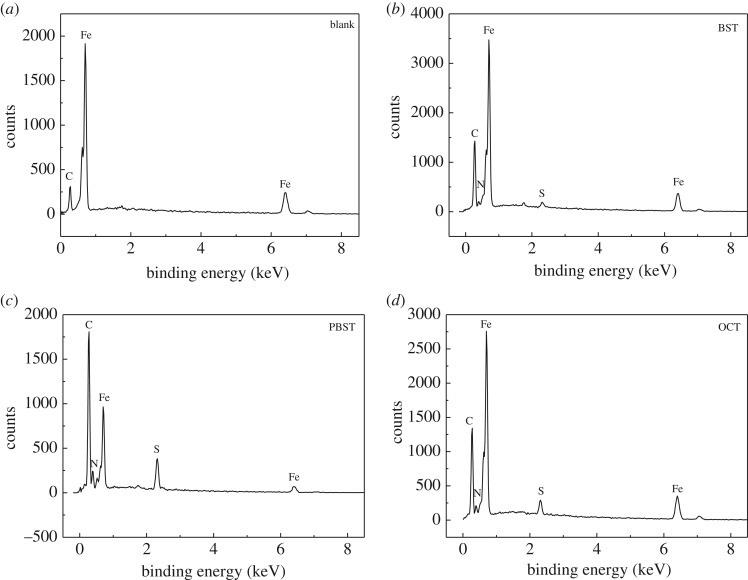
EDX spectra of Q235 mild steel surface in 0.5 M H2SO4 at 298 K in the absence (a) and presence of 300 µM (b) BST, (c) PBST and (d) OCT.